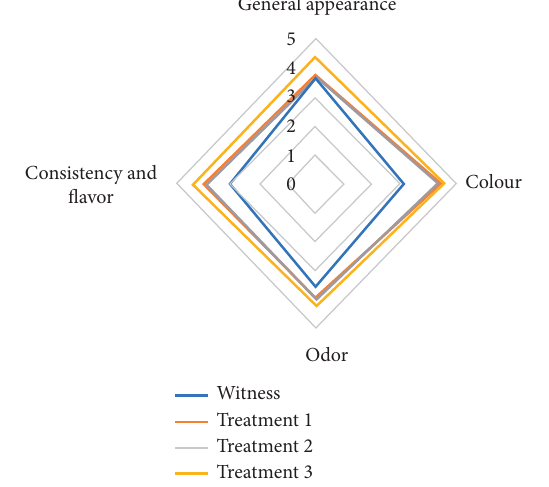
Figure 2: Evaluation of the sensory attributes of loquat compote ( Mespilus germ´anica L.).